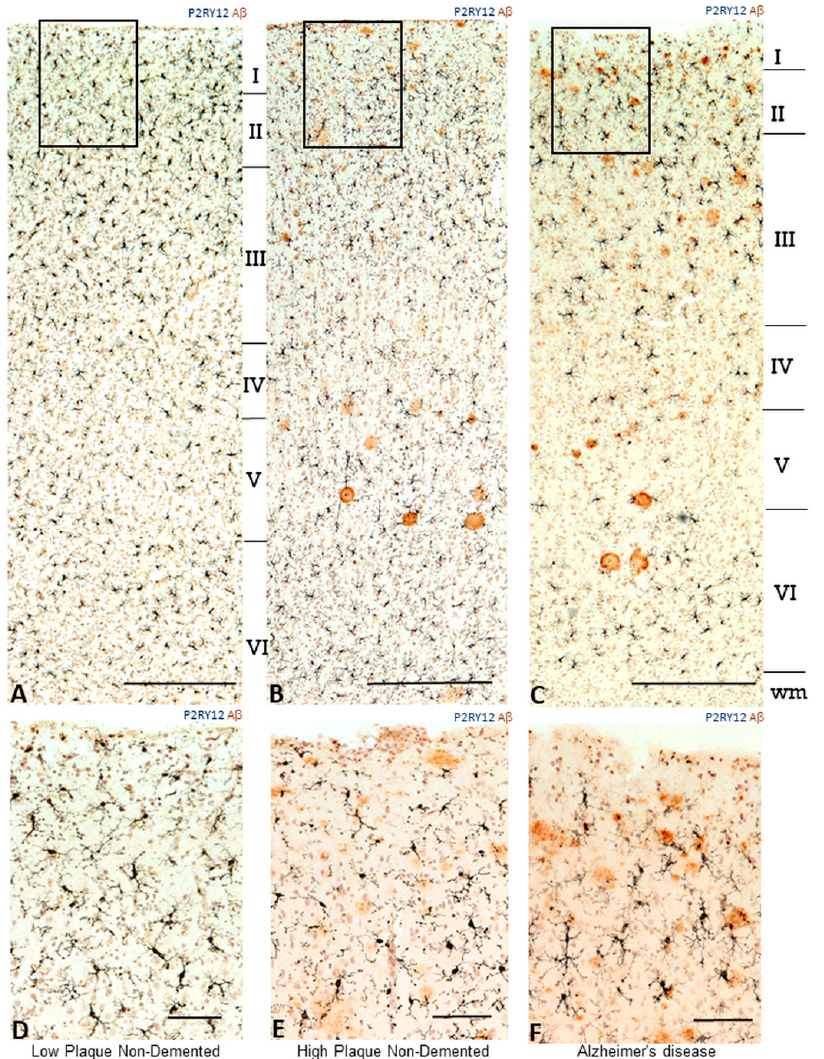
Figure 3. Distribution of P2RY12 microglia within cortical layers in relation to amyloid beta plaques in pathologically staged samples ( A – C ). Lower magnification photomicrographs showing the changes in P2RY12 microglia distribution compared to A β plaques within cortical layers of MTG. Sections from low plaque, high plaque and AD cases stained for P2RY12 (purple) and A β (brown). Sections were counterstained with neutral red to identity cellular morphology. Scale bars represent 200 µ